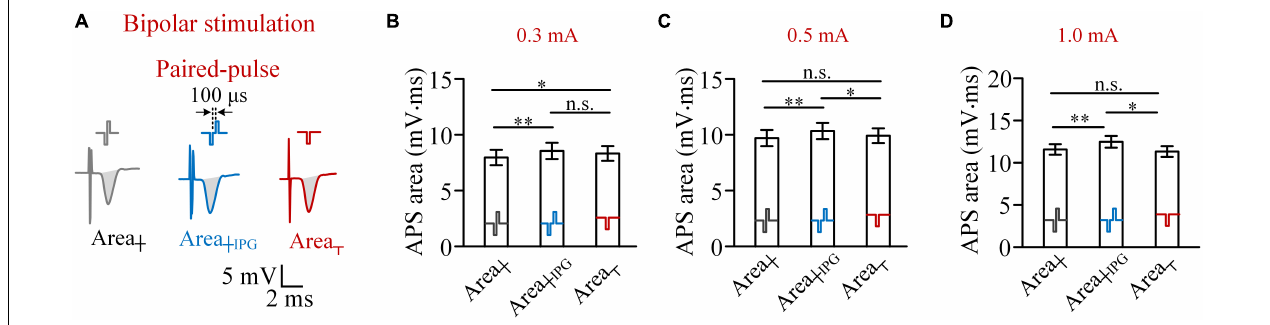
FIGURE 4 | Comparisons of areas of antidromically evoked population spike (APS) evoked by biphasic pulses, paired pulses, and cathodic pulses in bipolar stimulations. (A) Examples of APS evoked by the three types of pulses. (B–D) Comparisons of mean areas of APS evoked by the three types of pulses with pulse intensities of 0.3, 0.5 and 1.0 mA, respectively ( ∗ p < 0.05, ∗∗ p < 0.01; n.s., not significant, two-way ANOVA, post hoc least significant difference test, n =